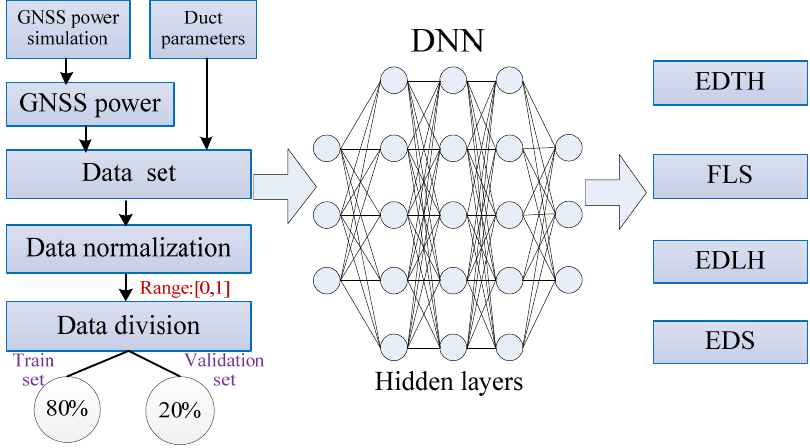
Figure 12. Duct parameter inversion framework based on the DNN.